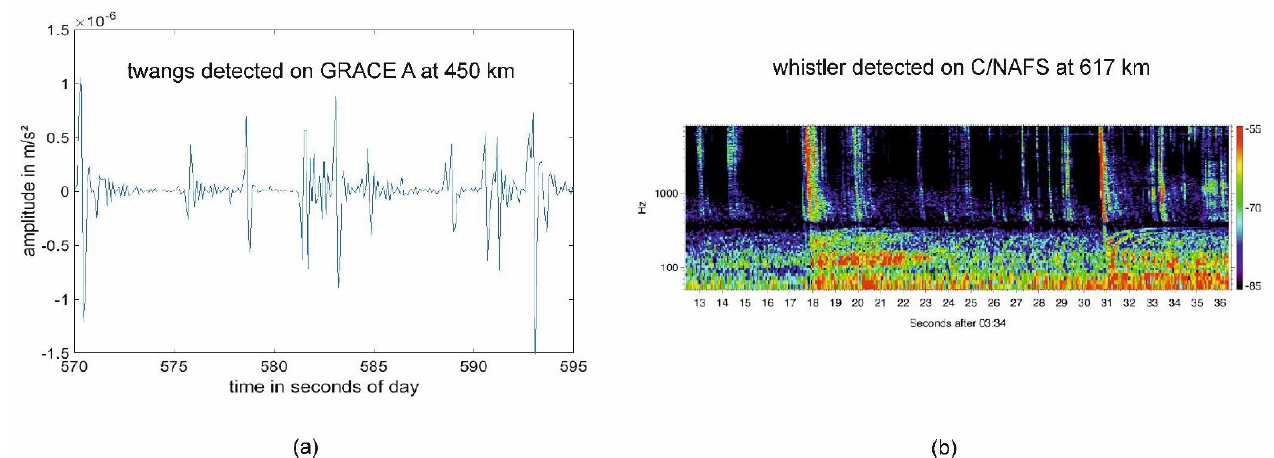
Figure 13. Comparison of the principal rate of twangs detected on GRACE ( a ) with the rate of whistlers detected on C/NAFS ( b ). These two plots are not taken at the same epoch nor at the same longitude. They simply serve as a comparison around the equator (with permission [26]).